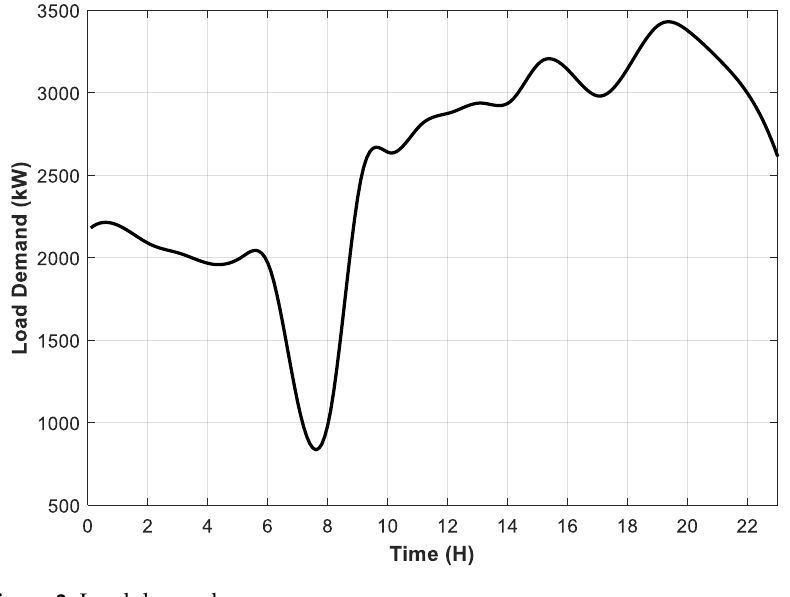
Figure 2. Load demand. Figure 2. Load